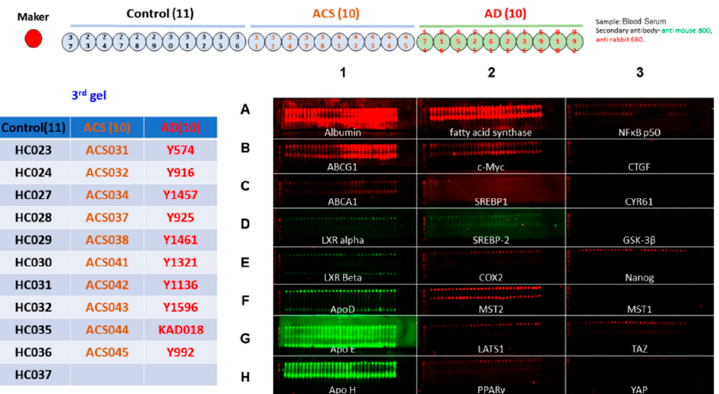
Figure 2. Images of Micro-Western Array analysis for analysis of serum protein expression profile in HC, ACS, and AD participants. The 31 health control samples, 30 ACS samples and 30 AD samples were separated into three MWA gel loading for analysis as gel 1, gel 2 and gel 3. The image showed the loading location of 11 healthy control, 10 ACS and 10 AD in each gel. Sample HC37 was loadined in each gel as standard for comparison between different blots. Red color and green color represented the two different laser in Licor scanner (680 nm and 780 nm wavelength, respectively) used to detect anti-rabbit and anti-mouse antibodies. The albumin was used as loading control. The samples were spotted into 24 wells and were labeled with row 1 to row 3 and column A to column H. In each well, the identical 30 samples were spotted by GeSim Nanoplotter and each well was loaded with one specific antibody as shown in the figure.